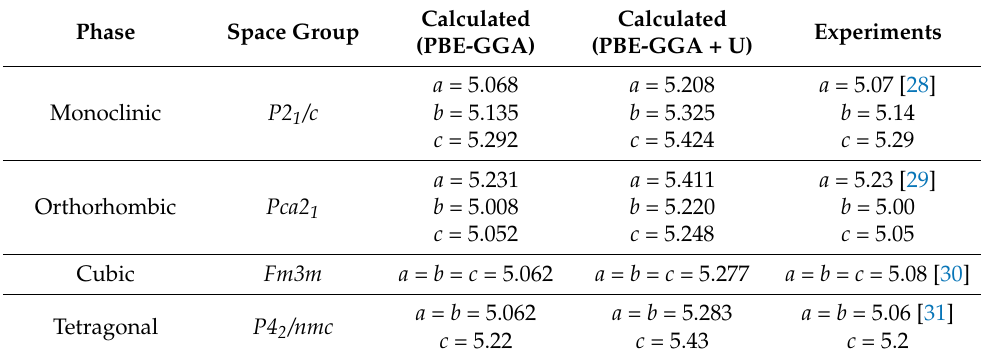
Table 1. Lattice Constants of HfO 2 Unit Cells (in